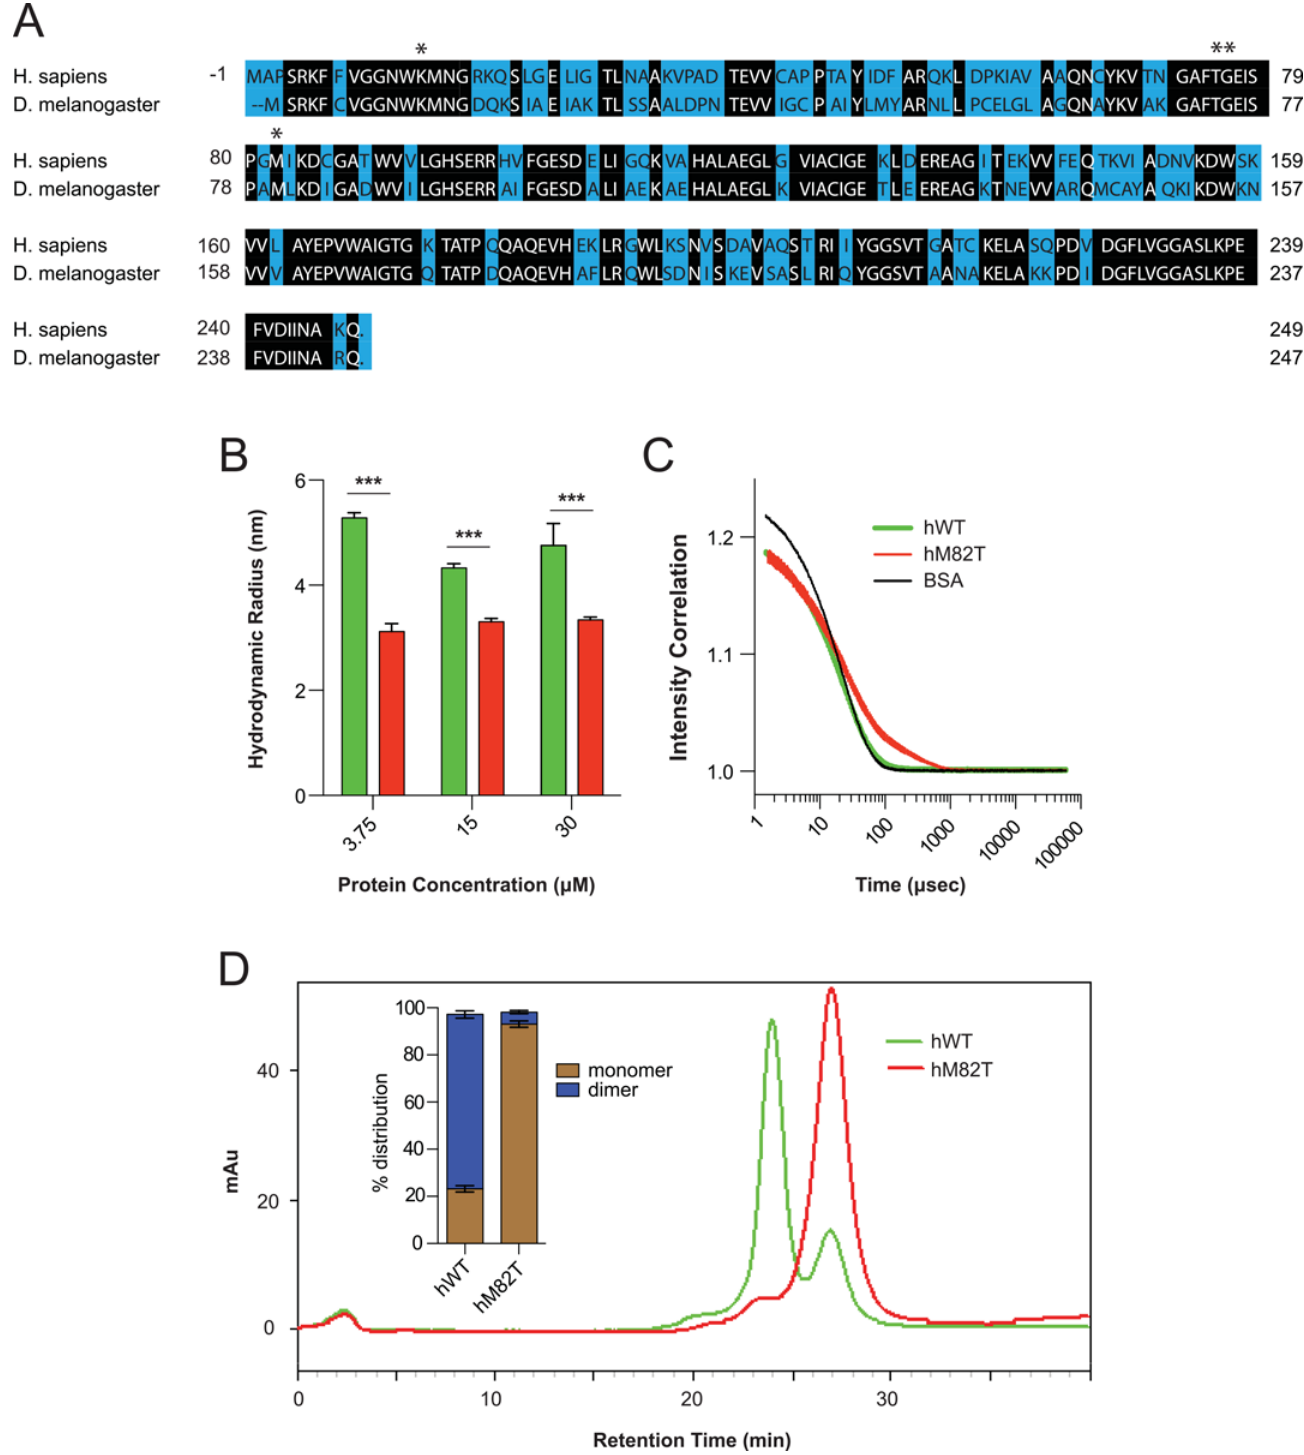
Fig 1. hTPI M82T elicits a conformational change in TPI resulting in reduced dimerization. (A) Sequence alignment of D . melanogaster and H . sapiens TPI protein sequence with asterisks highlighting residues of interest. (B) The hTPI M82T mutation confers a reduction in mean protein hydrodynamic radius as measured by dynamic light scattering. (C) Intensity correlation plots reveal a largely monodisperse hTPI WT population and polydisperse hTPI M82T population. (D) Gel filtration indicates a change in monomer:dimer ratios elicited by hTPI M82T with relative quantification (inset). n (cid:1) 3, comparisons were made using Student ’ s T test, *** indicates p <